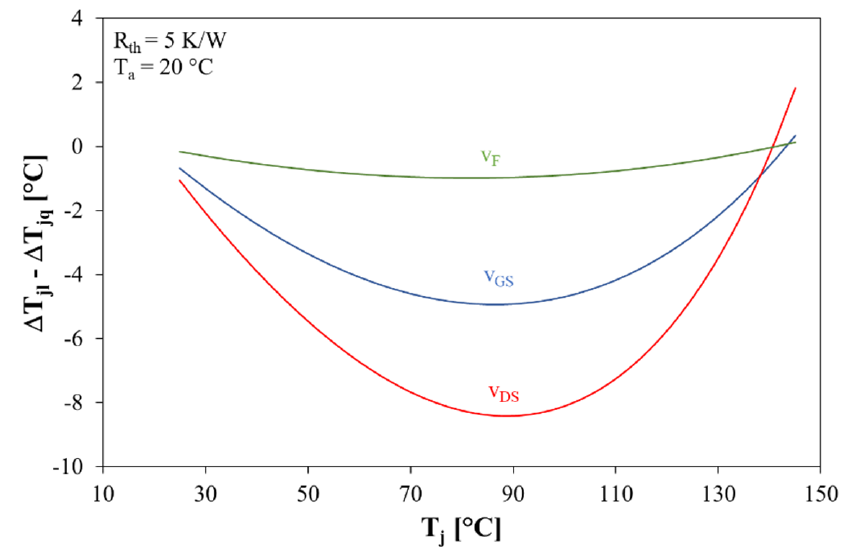
Figure 9. Dependences of the difference of an increase of the transistor M 1 die temperature that was computed using the linear ∆ T jl and the quadratic ∆ T jq approximations of the thermometric characteristics on the die temperature.